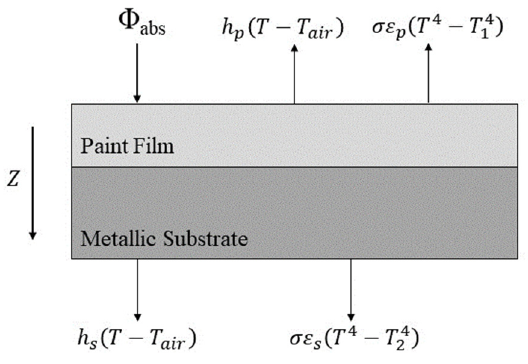
Figure 16. Heat transfer diagram for coating and substrate system (adapted from L. Véchot et al. [13]).